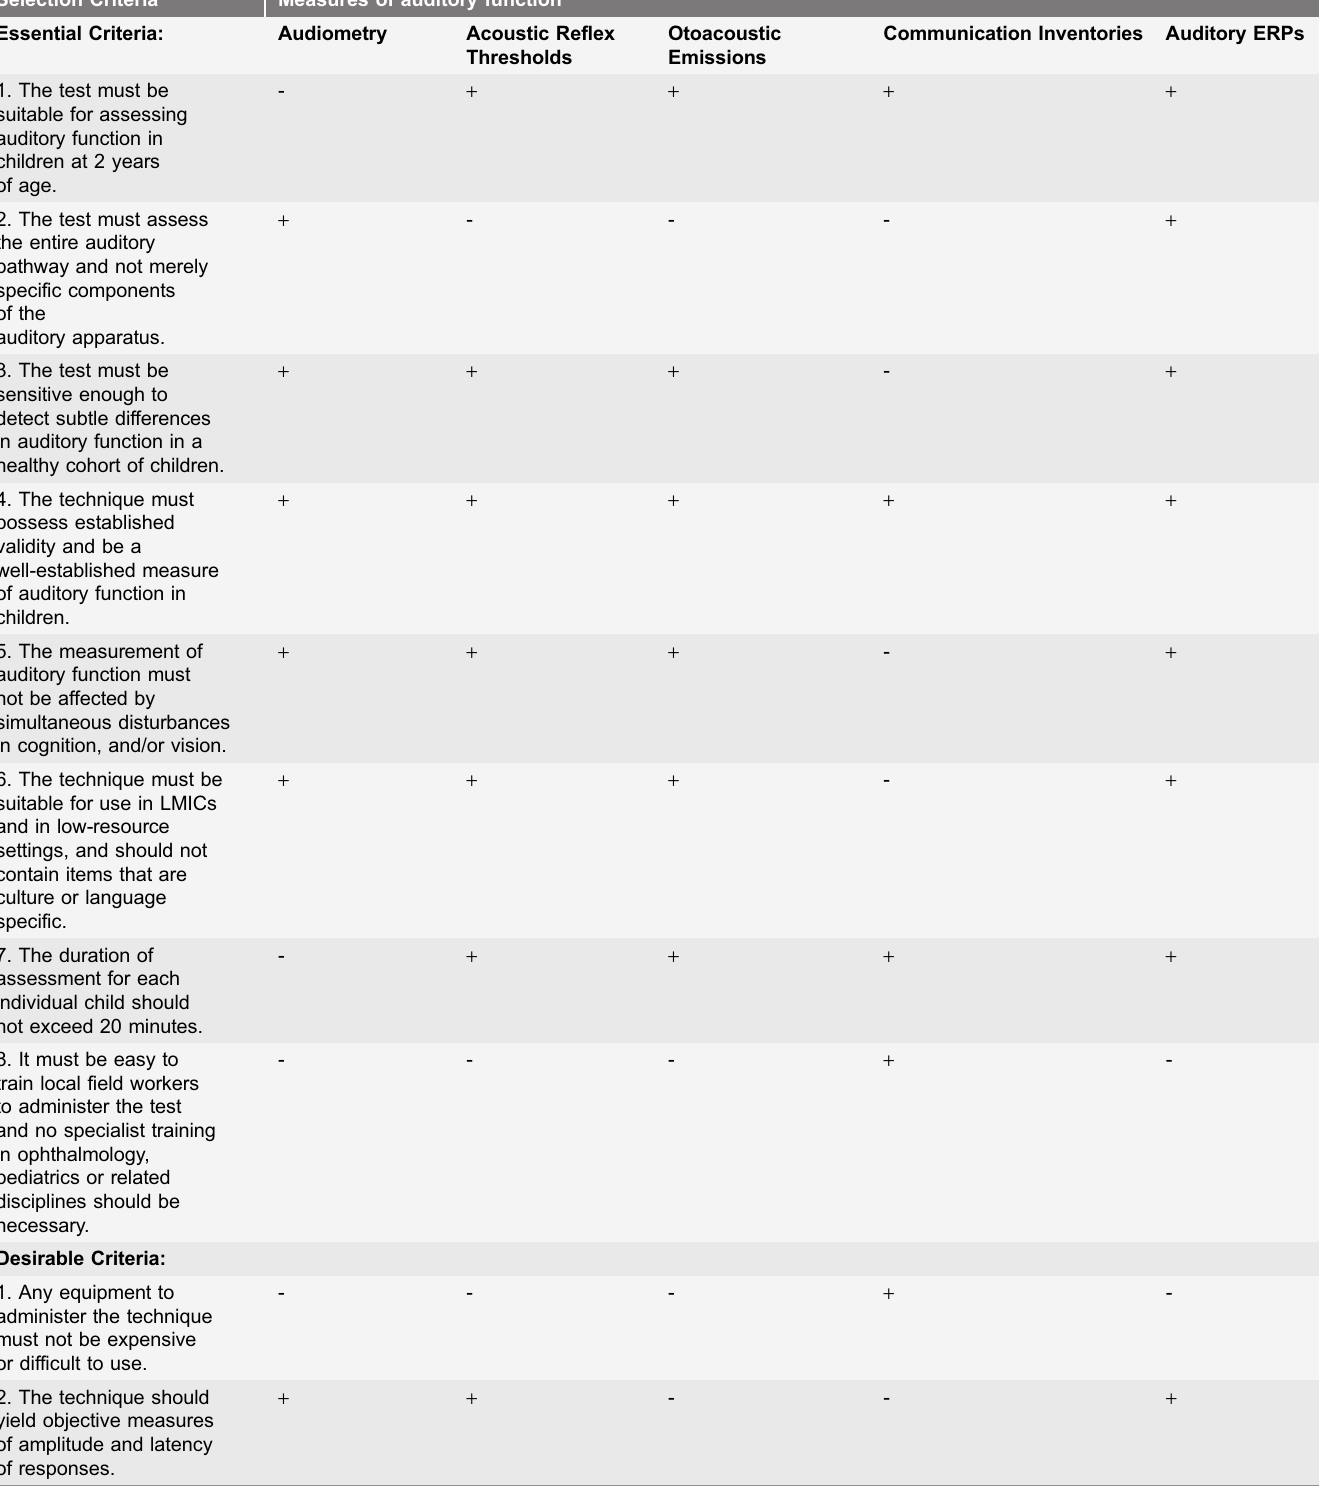
Table 10. Analysis of candidate auditory function tests against selection criteria. Selection